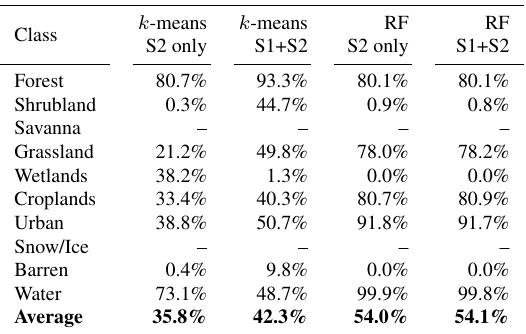
Table 4. Quantitative results achieved on the DFC2020 validation dataset for the shallow classifiers trained on the low-resolution labels of the DFC2020 validation set.